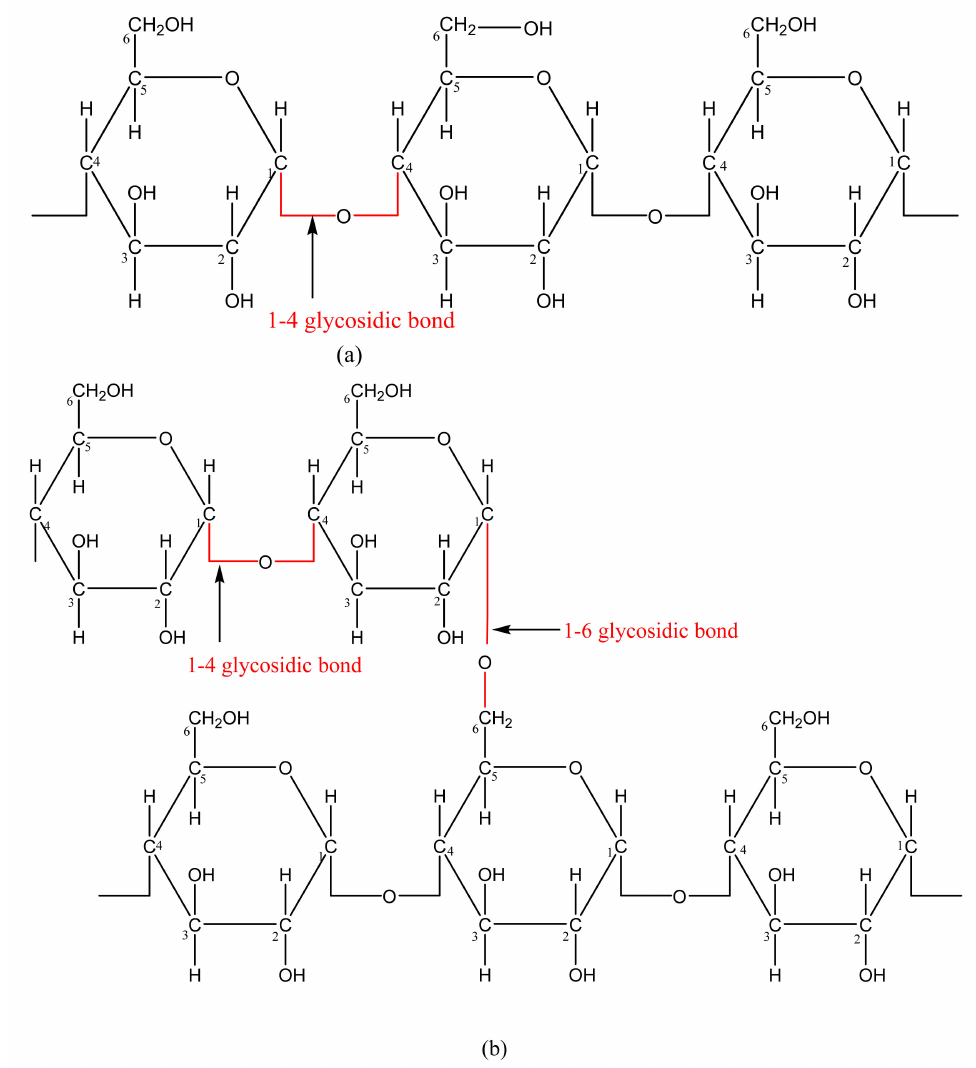
Figure 2. Chemical structure of ( a ) Amylose and ( b )